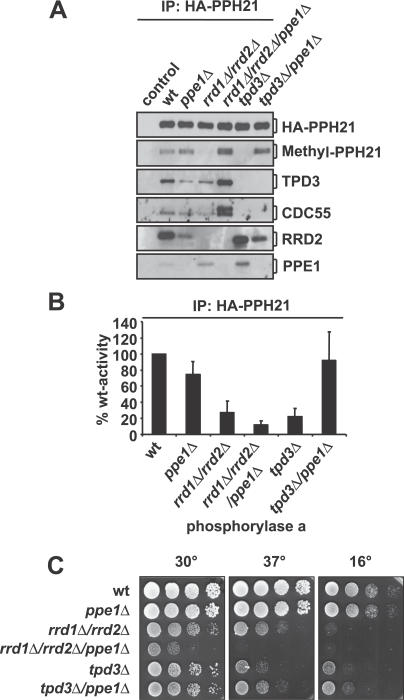
Deletion of PPE1 Restores C Subunit Catalytic Activity in the tpd3Δ, but Not in the rrd1Δ/rrd2Δ Strain(A) HA-tagged PPH21 was immunoprecipitated from lysates of wild-type (wt), ppe1Δ, rrd1Δ/rrd2Δ, rrd1Δ/rrd2Δ/ppe1Δ, tpd3Δ, and tpd3Δ/ppe1Δ cells. The immunoprecipitates were separated by 10% SDS-PAGE and analyzed by immunoblotting with anti-HA, anti-methyl PP2A, monoclonal anti-TPD3, anti-CDC55, anti-RRD2, and anti-PPE1 antibodies.(B) Aliquots of the anti–HA-tag immunoprecipitates used in (A) were assayed for phosphatase activity using phosphorylase a as substrate (n = 7).(C) Logarithmically growing cultures of wild-type, ppe1Δ, rrd1Δ/rrd2Δ, rrd1Δ/rrd2Δ/ppe1Δ, tpd3Δ, and tpd3Δ/ppe1Δ were 10-fold serially diluted in YPD liquid medium, spotted on YPD plates, and incubated at 16 °C for 5 d, or at 30 °C or 37 °C for 3 d.